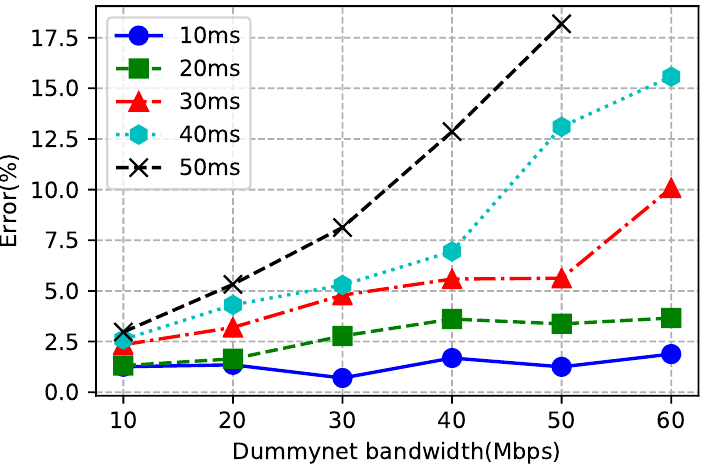
Figure 7. Dummynet bandwidth comparing to iPerf